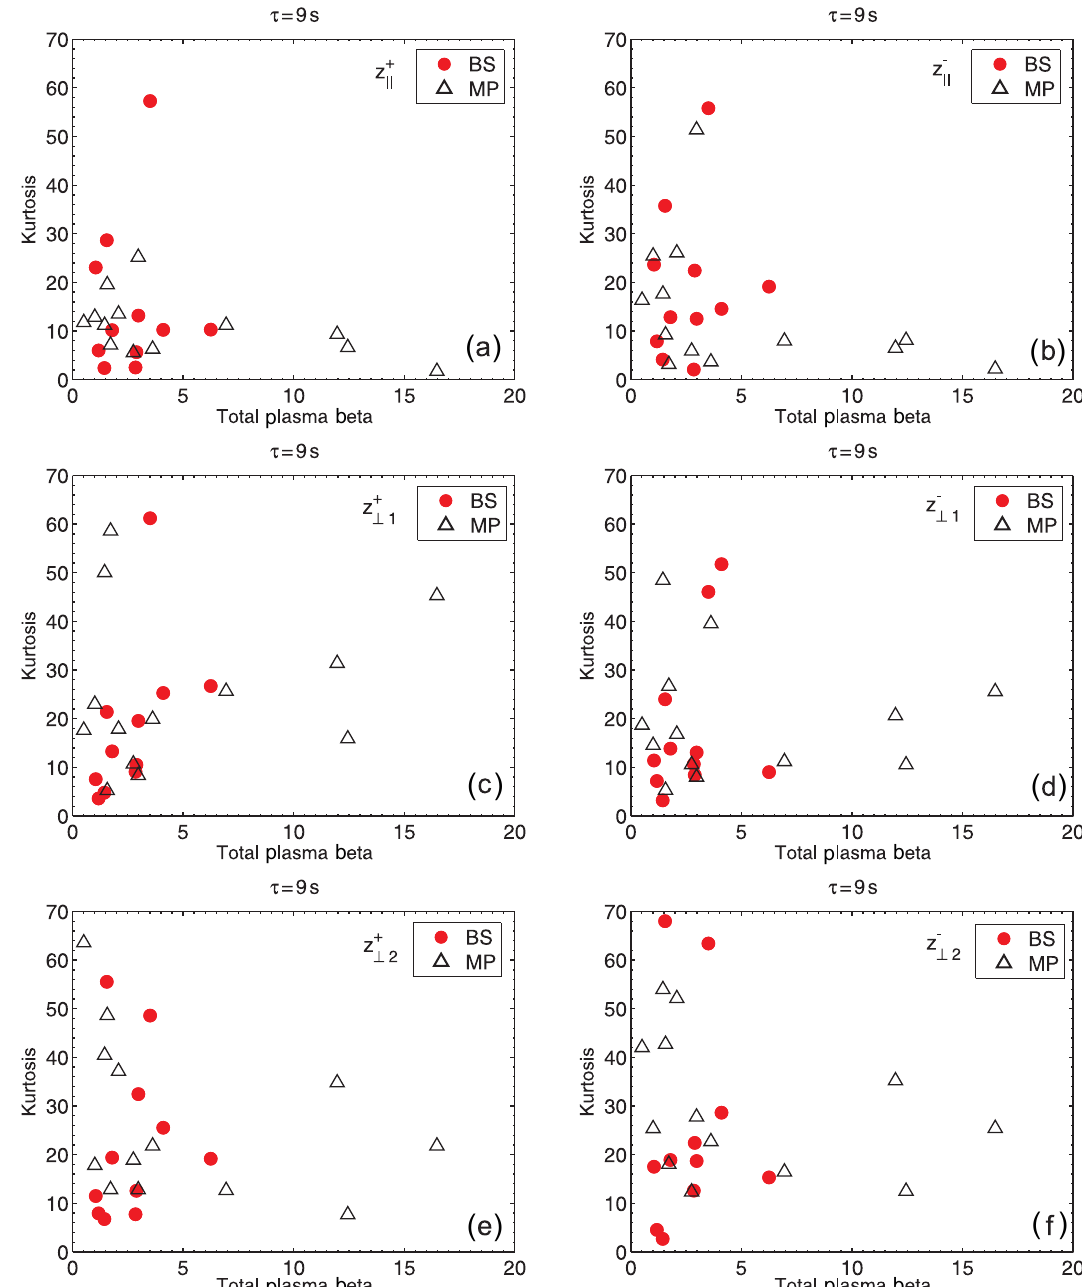
Figure 10. Kurtosis of the increments of the Elsässer vectors, δ z ± , in the magnetosheath vs. the total plasma beta β for the components δz ± (cid:107) (parallel to the mean field vector B o , panels a and b ) and two components perpendicular to the field: (1) δz ± ⊥ (in the plane containing B o 1 and the X axis in the GSE system, panels c and d ), and (2) δz ± ⊥ (perpendicular to the plane, panels e and f ) near the bow shock (BS, red 2 circles) and near the magnetopause (MP, white triangles), as observed by THEMIS for samples listed in Table 2. topause, cases (c) and (d), for a given timescale τ = 9 s,